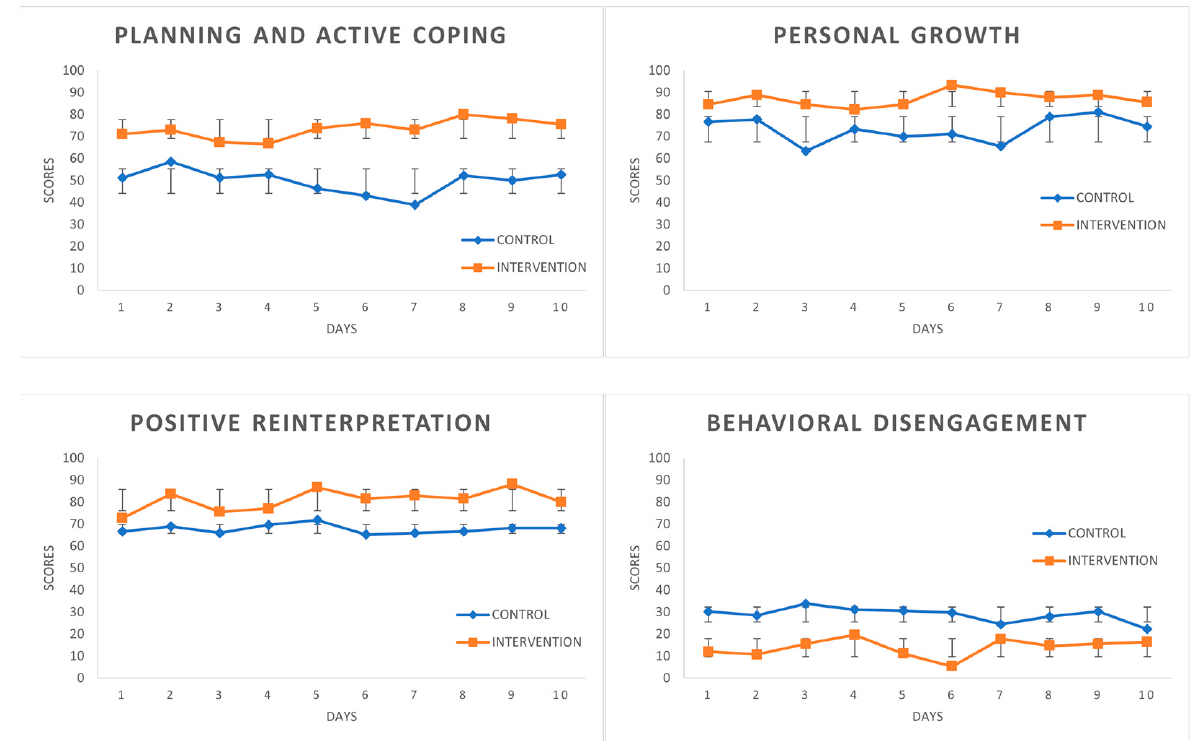
Int. J. Environ. Res. Public Health 2021 , 18 , x